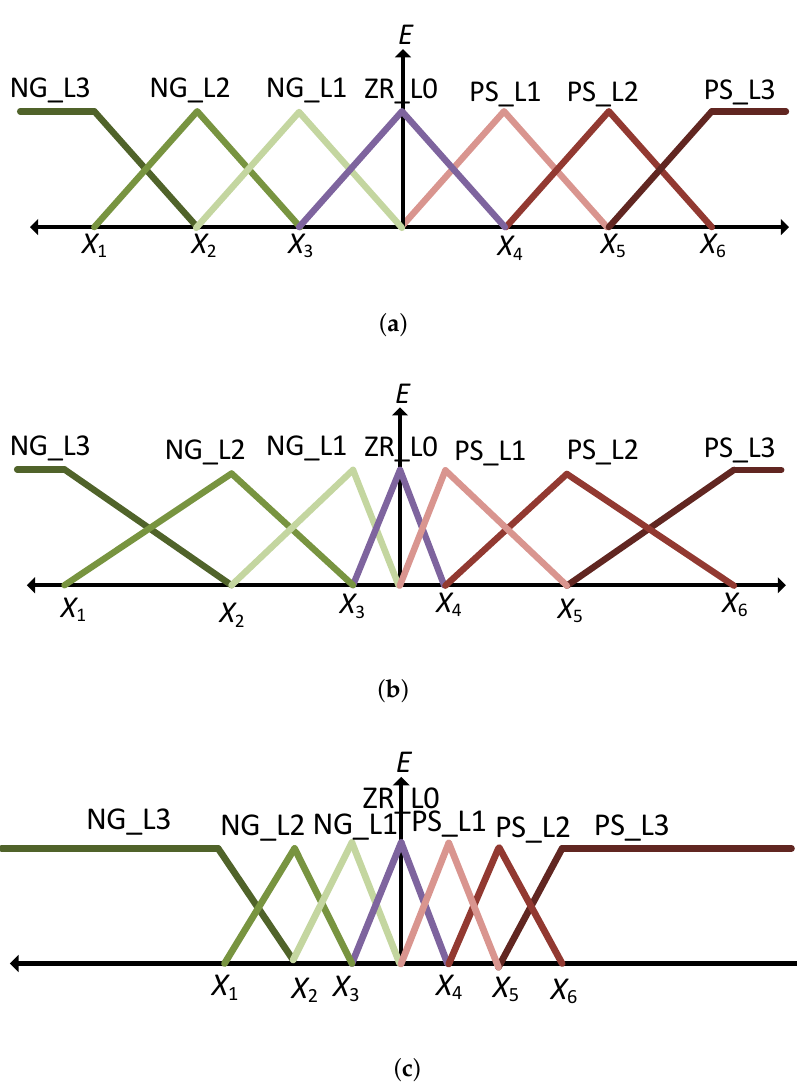
Figure 9. Design optimization of MFs points; ( a ) Original MF of E dP / dI ( k ) ; ( b ) Optimized MF design case 1; ( c ) Optimized MF design case